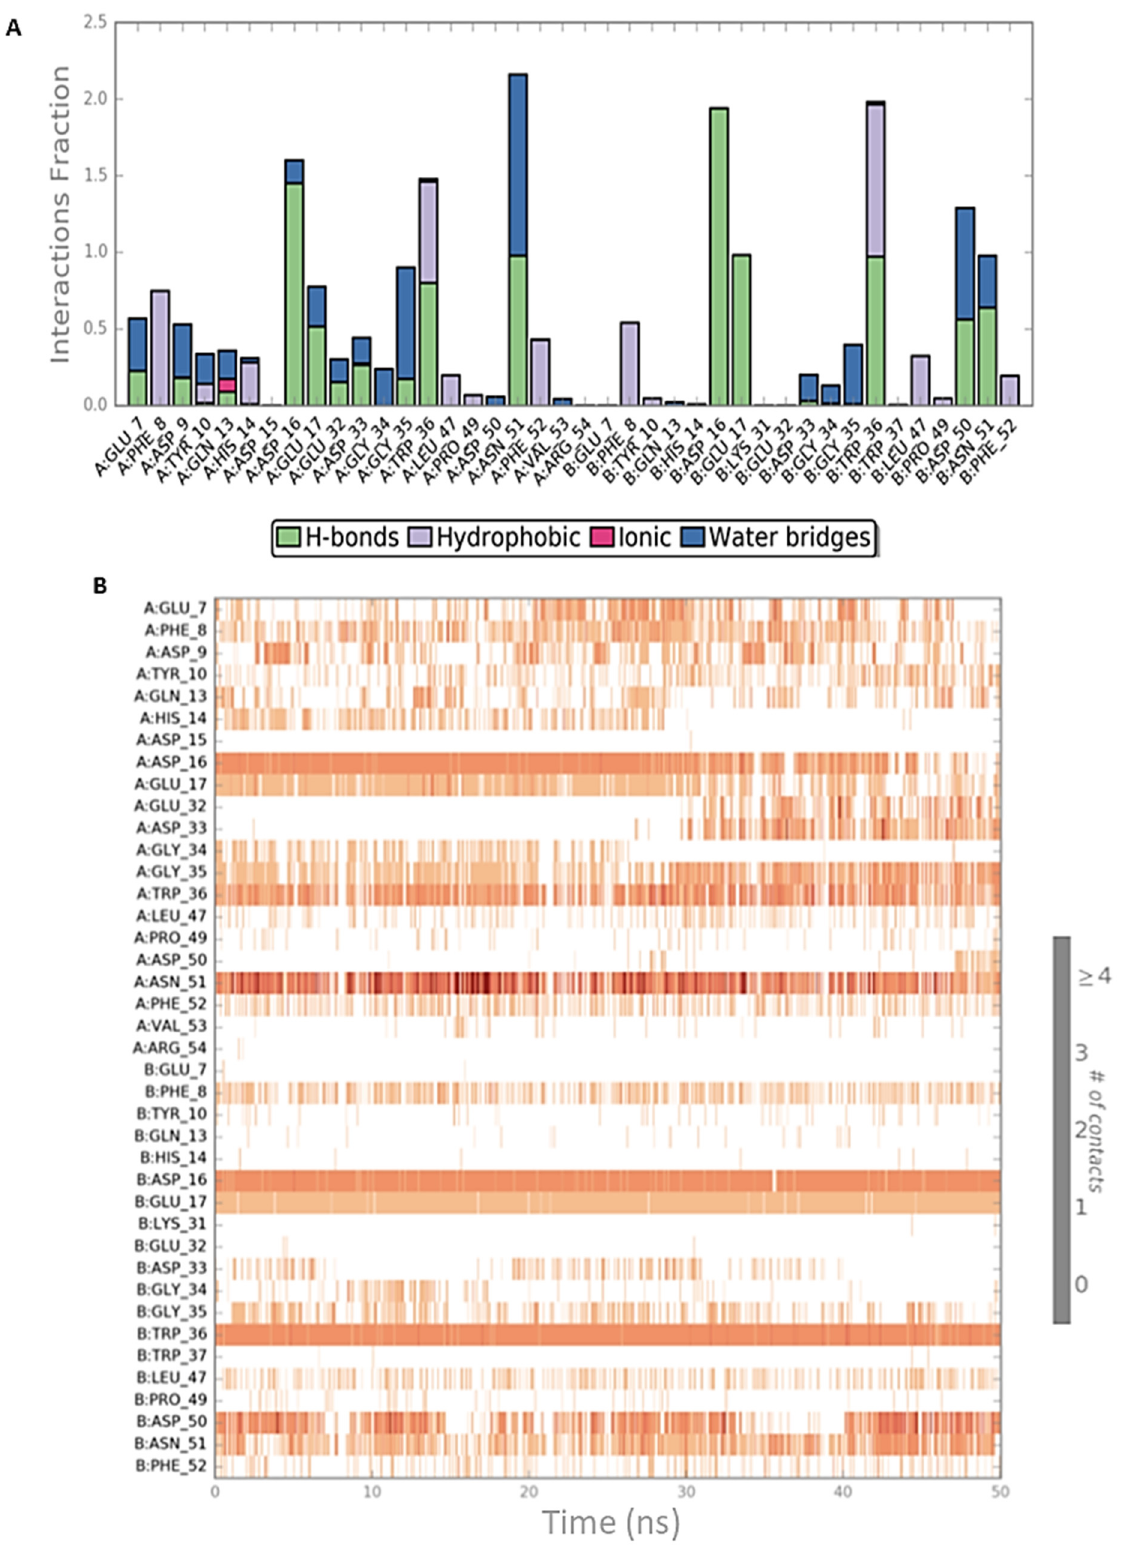
Figure 3. Schematic representations of the interactions occurring in the first MD simulation of CIN85-Cbl-b complex from PDB 2BZ8. ( A ) Histogram plot highlighting the CIN85 residues involving in the interactions with Cbl-b. ( B ) Timeline representations of the interactions during the MD simulation.